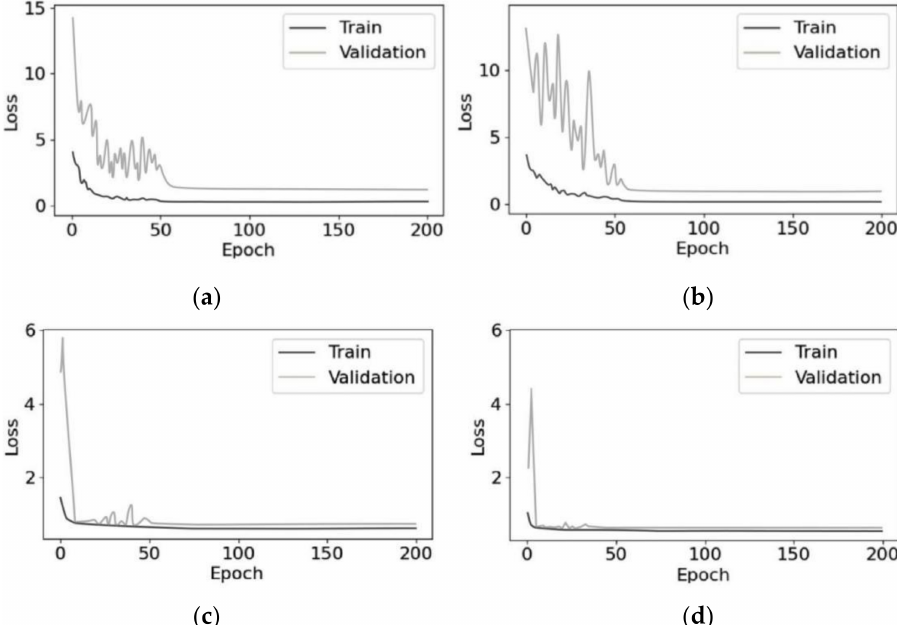
Figure 9. Training and validation results by different methods. ( a ) U-Net, ( b ) FCN, ( c ) YOLO v5, ( d )